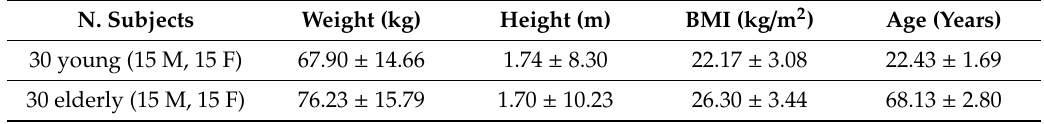
Table 1. Participants’ anthropometric characteristics.